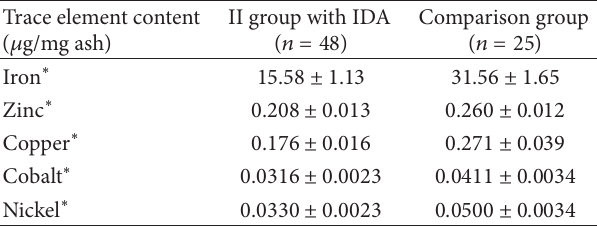
Table 2: Content of trace element in erythrocytes in children with IDA and healthy